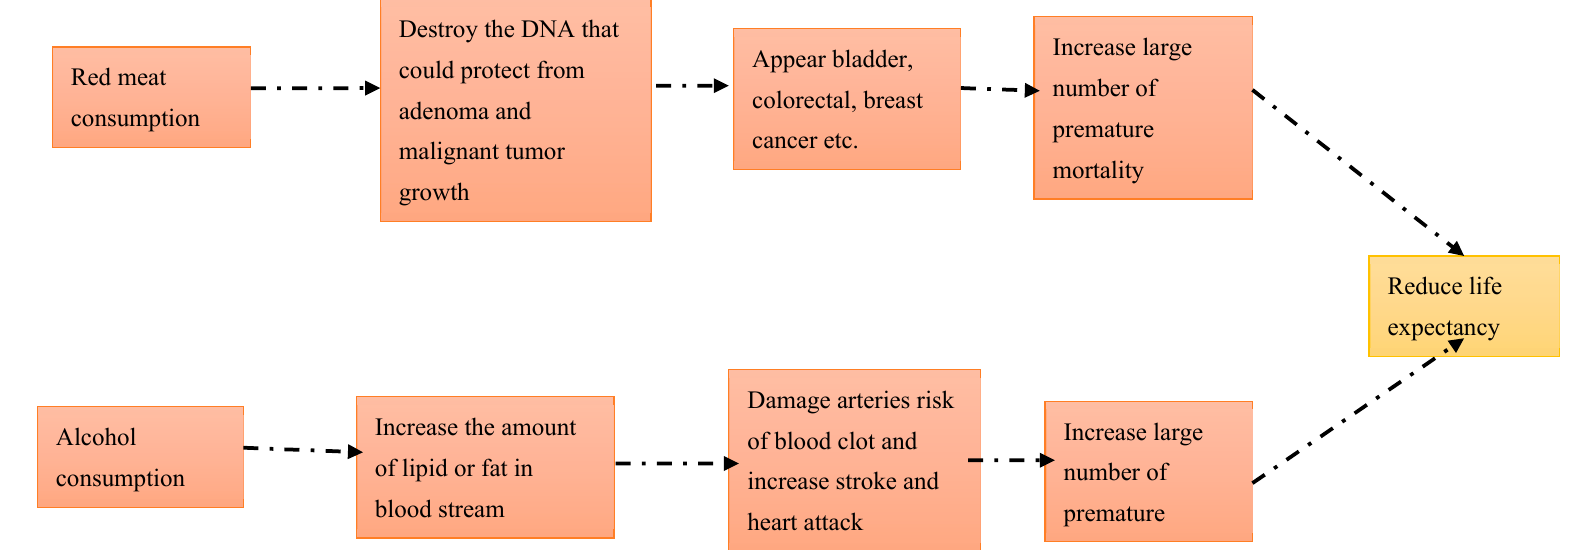
Figure 1. Conceptual framework on red meat and alcohol consumption associated with life expectancy.